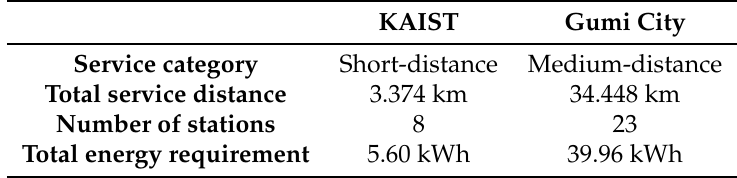
Table 2. Bus category according to service